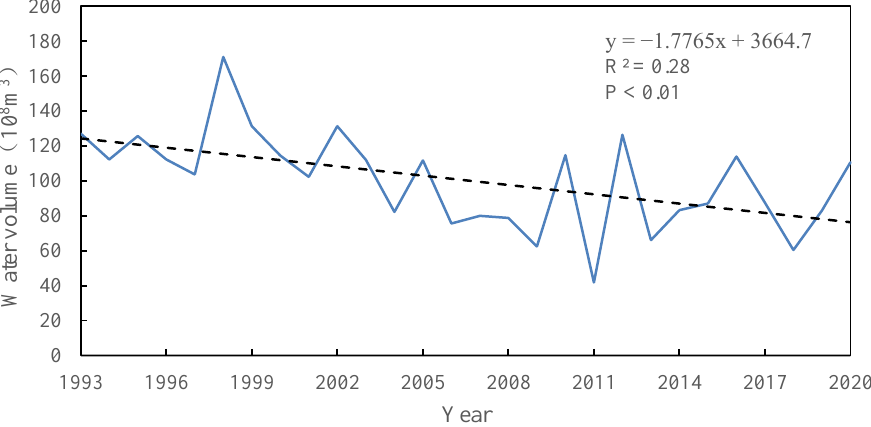
Figure 12. The inter-annual variations of Poyang Lake’s water volume from 1993 to 2020: the blue line is the water volume, and the black dotted line is the linear regression line.